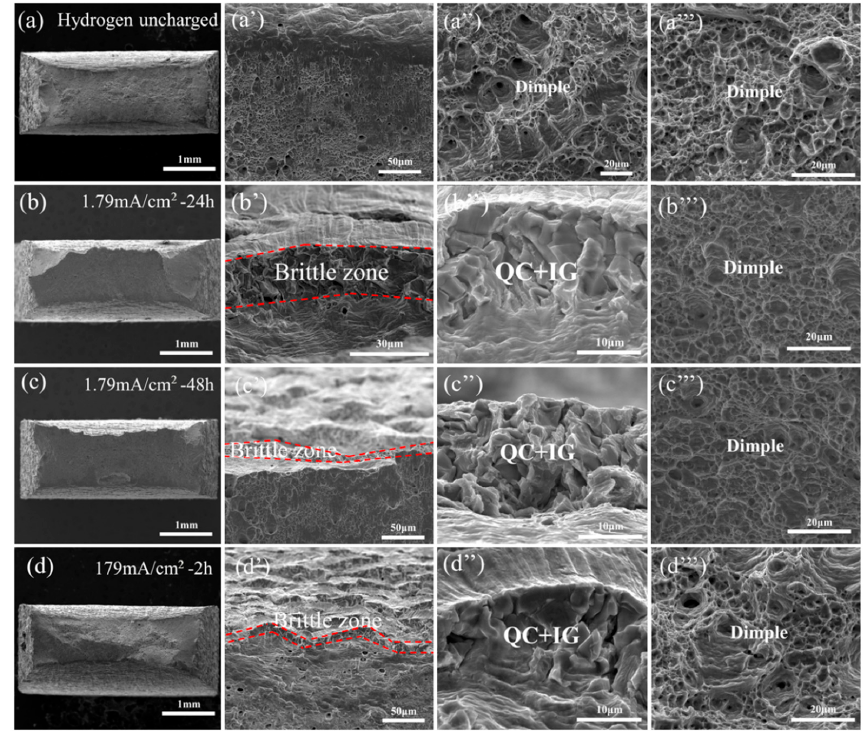
Figure 4. SEM images of hydrogen-charged and uncharged samples of CoCrFeMnNi subjected to various charging parameters viewed from top side. ( a – a (cid:48)(cid:48)(cid:48) ) uncharged; ( b – b (cid:48)(cid:48)(cid:48) ) 1.79 mA cm − 2 for 24 h; ( c – c (cid:48)(cid:48)(cid:48) ) 1.79 mA cm − 2 for 48 h; ( d – d (cid:48)(cid:48)(cid:48) ) 179 mA cm − 2 for 2 h. IG: intergranular fracture; QC: quasi-cleavage fracture.